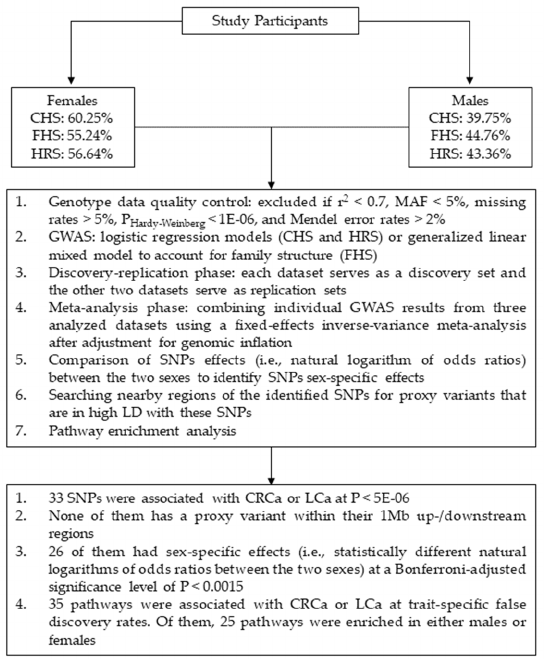
Figure 1. Schematic summary of the analysis steps and main findings of this study. Abbreviations: CHS = Cardiovascular Health Study; FHS = Framingham Heart Study; HRS = Health and Retire- ment Study; CRCa = colorectal cancer; LCa = lung cancer; SNP = single-nucleotide polymorphism; MAF = minor allele frequency; GWAS = genome-wide association study; LD = linkage disequilib- rium.